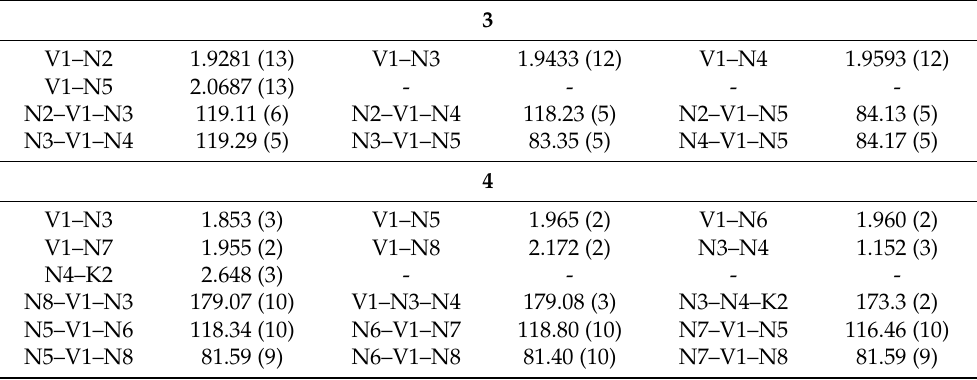
Table 2. Selected bond lengths (Å) and angles (deg) for 3 and 4 .